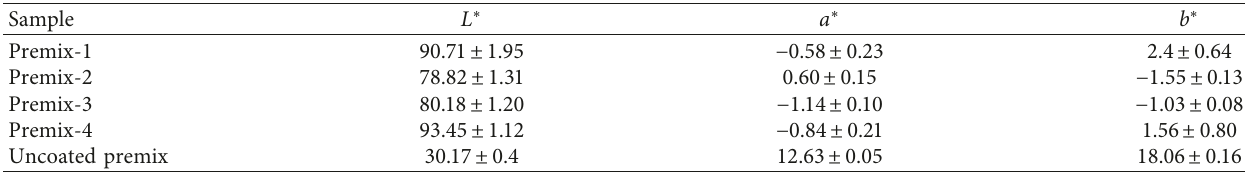
Table 1: ( L ∗ a ∗ b ) colour space value of all premixes and uncoated extruded ferrous fumarate. A higher L value indicates whiteness, and a lower L indicates darkness.